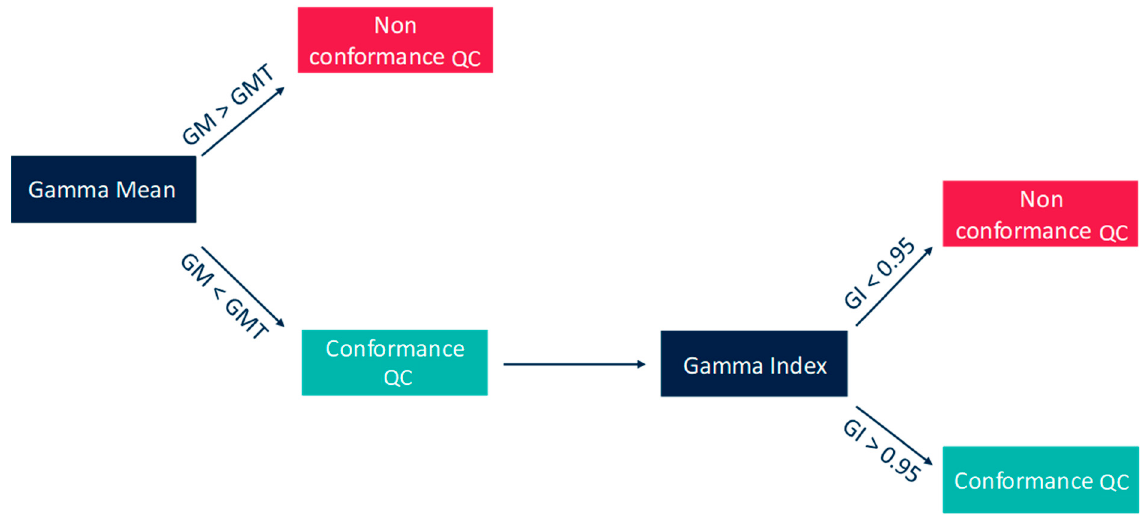
Figure 1. Decision tree of the QC conformance using gamma index and gamma mean.